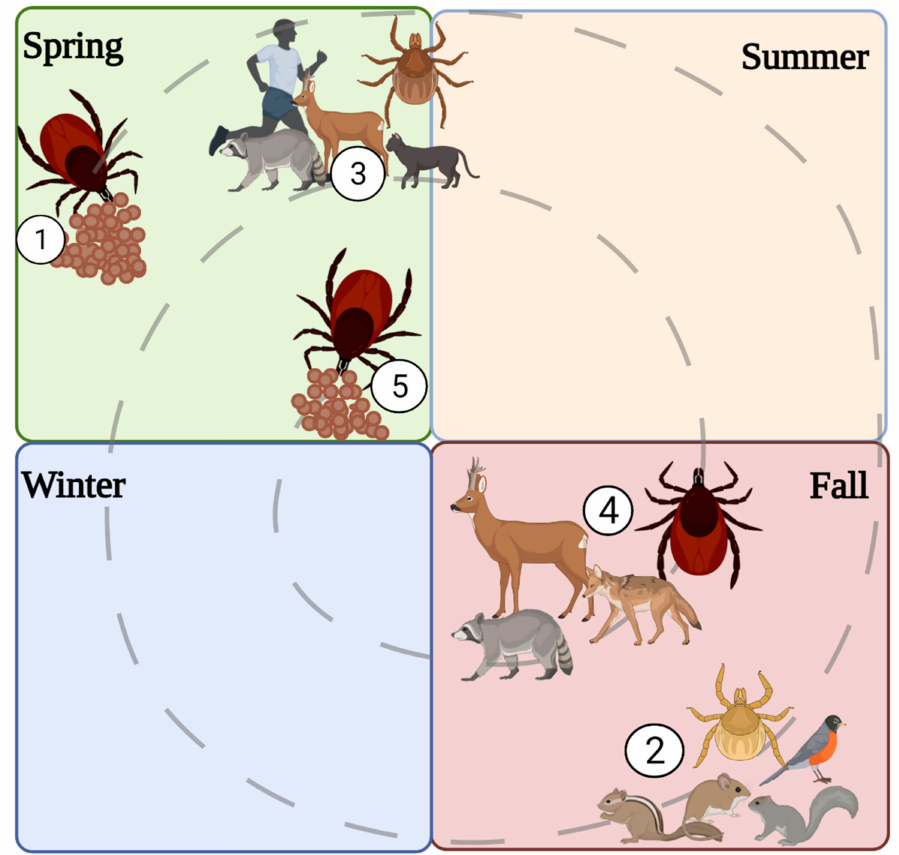
Figure 5. Life cycle of I. scapularis . (1) Female tick lays eggs in the spring. (2) The larvae hatch in the fall and feed on small mammals and birds. (3) The larvae overwinter and molt into nymphs. The nymph’s quest on medium to large mammals. (4) The nymphs molt into adults, and the adults quest on large mammals. (5) The adults overwinter, and the females lay eggs in spring and then die. Illustrations were created using Biorender (biorender.com, accessed on 30 September